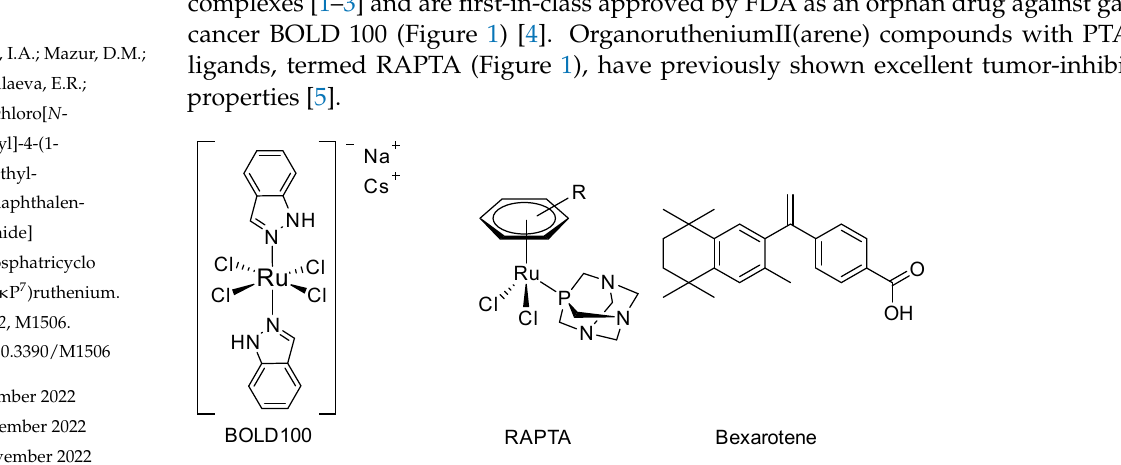
Figure 1. The structure of BOLD-100, RAPTA and